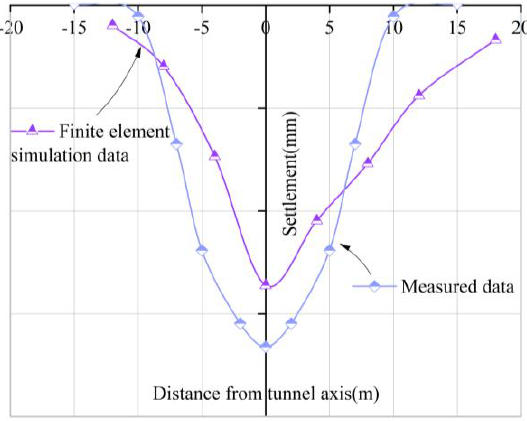
Figure 7. Comparison of monitoring data and numerical model surface transverse curve.